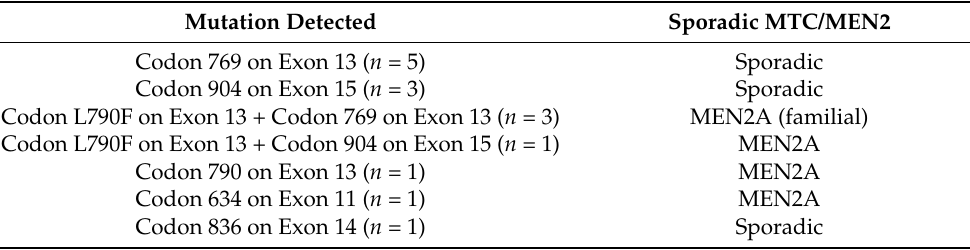
Table 2. Rearranged during transfection (RET) mutations detected in the study group. Mutation Detected Sporadic MTC/MEN2 Codon 769 on Exon 13 ( n = 5) Sporadic Codon 904 on Exon 15 ( n = 3) Sporadic Codon L790F on Exon 13 + Codon 769 on Exon 13 ( n = 3) MEN2A (familial) Codon L790F on Exon 13 + Codon 904 on Exon 15 ( n = 1) MEN2A Codon 790 on Exon 13 ( n = 1) MEN2A Codon 634 on Exon 11 ( n = 1) MEN2A Codon 836 on Exon 14 ( n = 1) Sporadic n , number of patients; MEN, multiple endocrine neoplasia.